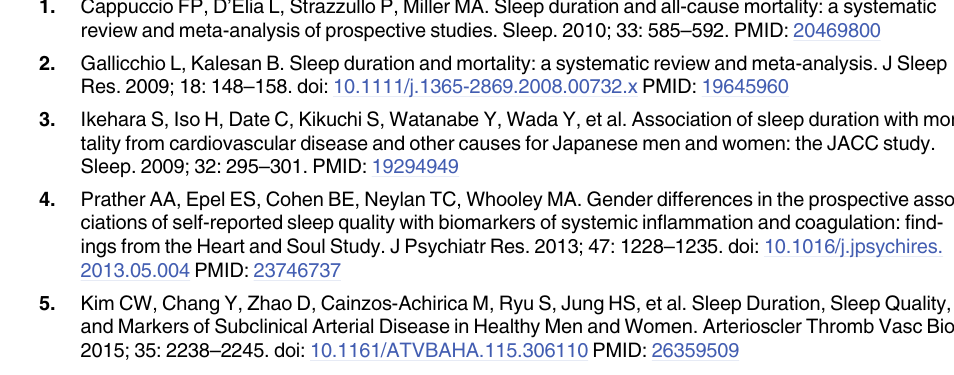
S2 Table. Regression coefficient from the multivariate logistic regression model. Abbrevia- tions: GERD, gastroesophageal reflux